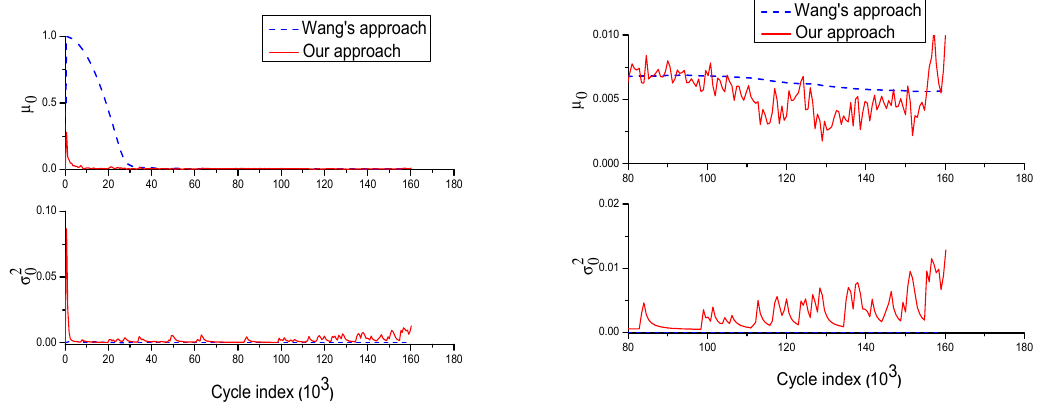
Figure 7. Compare the last 80 sampling points of the model parameters.